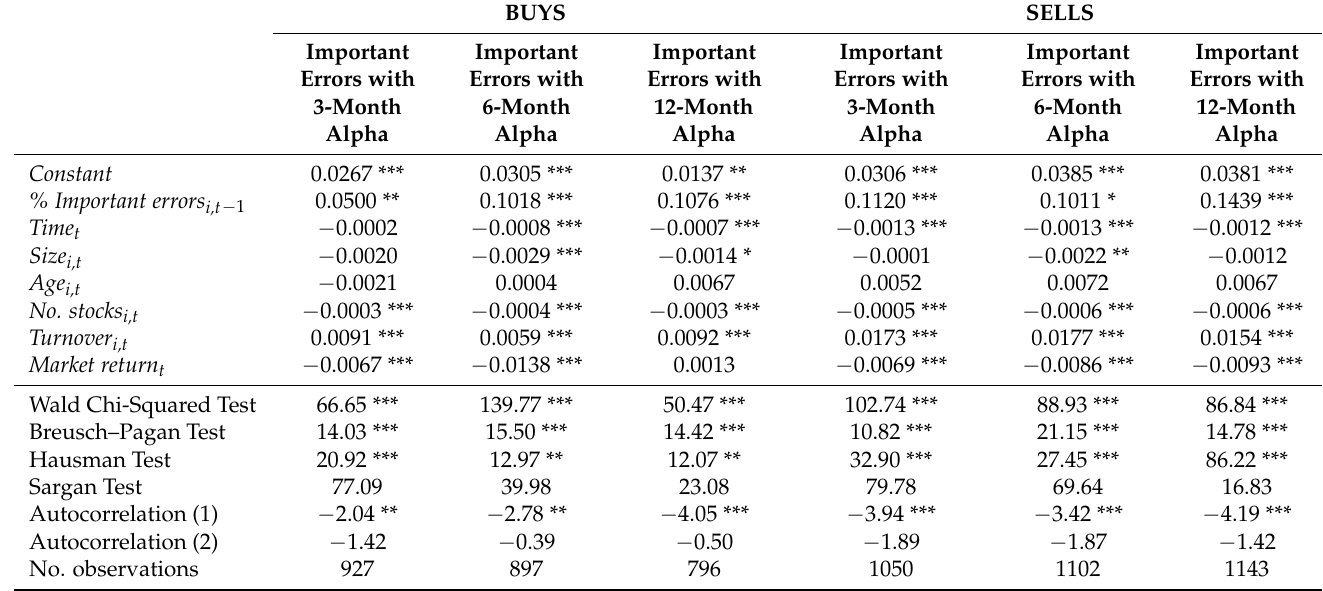
Table 4. Learning results in Euro non-domestic equity mutual funds. This table presents the results of Equation (14) for Euro non-domestic equity mutual funds from January 2000 to March 2014. The learning results are divided into buys and sells after considering different time horizons to compute the subsequent effect of these errors: 3-month alpha, 6-month alpha, and 12-month alpha. The dependent variable % Important errors i,t is the percentage of important errors for fund i in year t . The explanatory variables which are included in this table are: % Important errors i,t − 1 is the 1-year lag of the dependent variable regardless of the time horizon computed; % Important errors i,t − 1 is the 1-year lag of the dependent variable; Time t ranges from 1 in the first year of our sample period to 15 in the last year; Size i,t is the TNA of mutual fund i divided by the average TNA of all funds included in our sample in year t ; Age i,t is the normalized age of mutual fund i given that we divided the age of each fund by the average age of all funds included in our sample in year t to avoid correlation problems with the time variable; No. stocks i,t is the number of different stocks held by mutual fund i in year t ; Turnover i,t is the turnover ratio of mutual fund i in year t ; and Market return t is the EuroStoxx-50 total return in year t. We use the EuroStoxx-50 as the benchmark for Euro equity mutual funds. *** Significance at 1% level; ** significance at 5% level; * significance at 10%